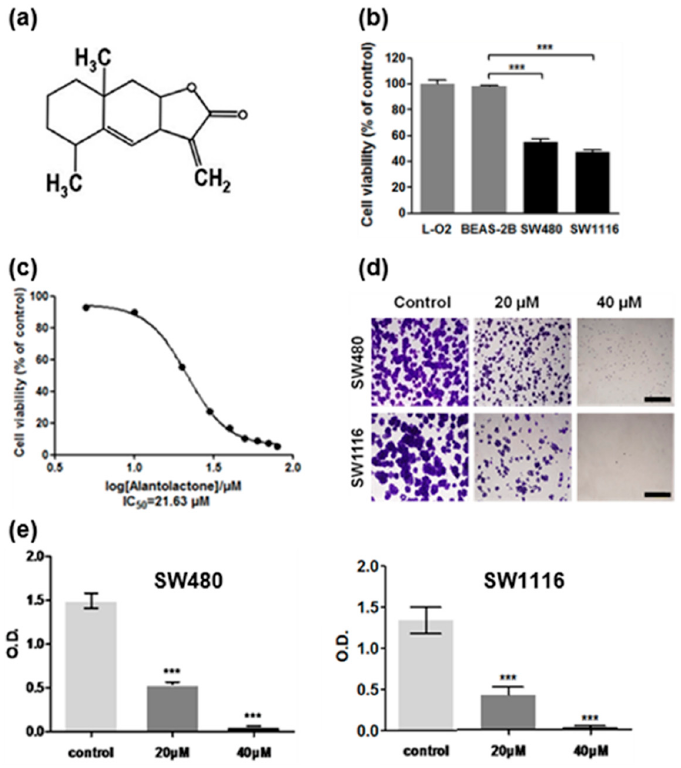
Figure 1. Alantolactone (ATL) potently suppressed the growth of the SW480 and SW1116 colorectal cancer cells. ( a ) Chemical structure of ATL; ( b ) ATL cytotoxicity determined by the MTT assay: treatment by 20 μ M ATL for 24 h potently suppressed the growth of SW480 and SW1116 colorectal cancer but not the non-cancer BEAS-2B and L-O2 cells (each treatment was done in triplicate, *** p < 0.001 vs. BEAS-2B); ( c ) Detailed dose-response studies: 24 h treatment by ATL inhibited the proliferation of SW480 and SW1116 cancer cells with an IC 50 of 21.63 and 18.14 μ M, respectively; ( d ) Confirmation of anti-proliferative effects by the colony formation assay: SW480 and SW1116 cells formed much fewer and smaller colonies after treatment by 20 and 40 μ M ATL for seven days (scale bar = 1 mm); ( e ) Quantification of colony formation assay results from three independent experiments: data were shown as average ± SD (*** p < 0.001 vs. vehicle control).